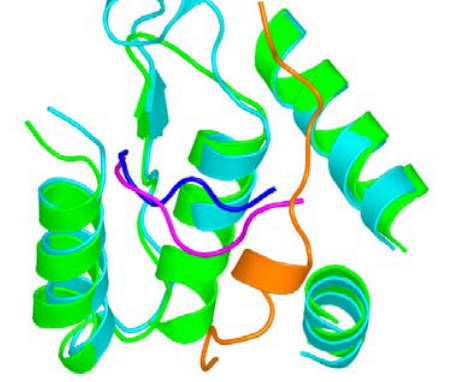
Figure 7. View of the structural comparison of ScRR2, ScRR4 and EcRR2 peptide binding. Carbon atoms for ScRR2 peptide (magenta), ScRR4 peptide (blue) and EcRR2 peptide (orange). Nearby helices are drawn from the ScRR1-ScRR2 complex (green) and EcRR1-EcRR2 complex (cyan). The figure was reproduced with permission from PNAS [12]. Copyright (2006) National Academy of Sciences,